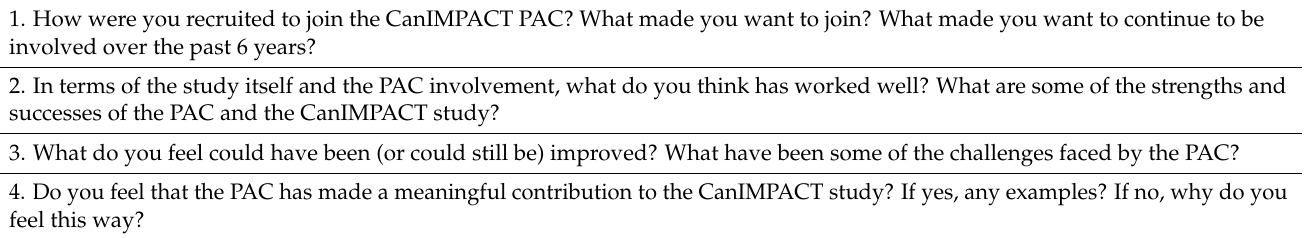
Table 1. Questions for PAC Member Reflective